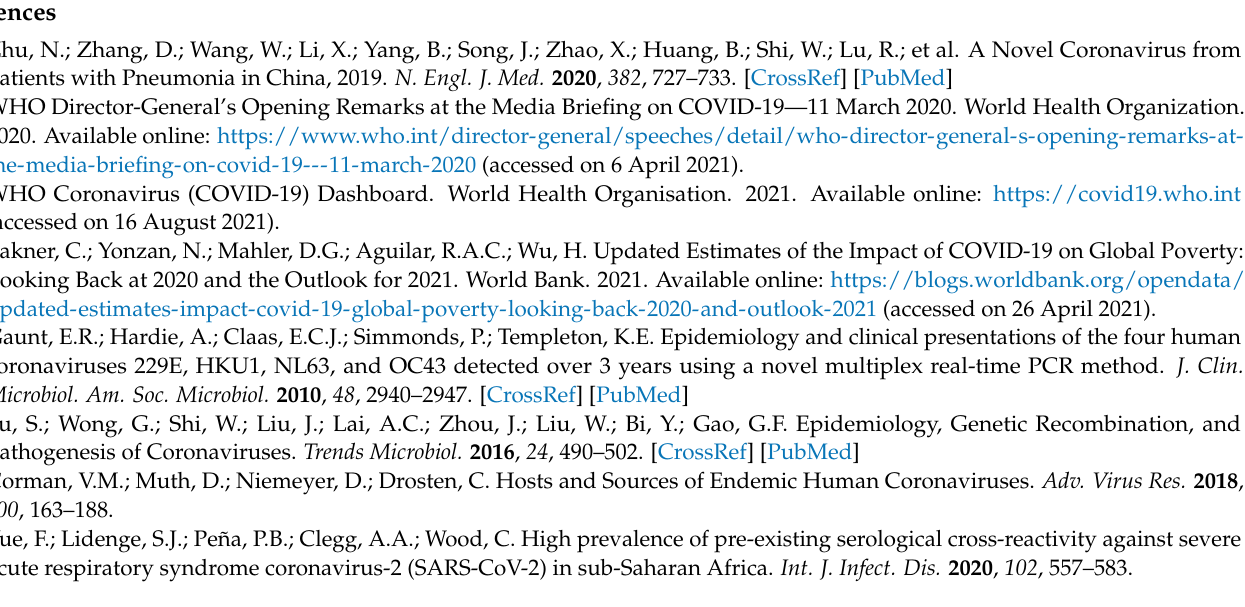
Figure S2: Reactivity to SARS-CoV-2, OC43, HKU1, NL63, 229E spike and N antigens in pre-pandemic and SARS-CoV-2 PCR-positive human serum samples; Figure S3: Inferring endpoint titers from minimal dilution series; Figure S4: Dilution series of OC43 and HKU1 S1S2; Table S1: Summary of human serum panels; Table S2: Comparison of inflection titers inferred from 8 dilutions and 3 spread out dilutions (1:40; 1:640; 1:10,240) for three SARS-CoV-2 antigens; Table S3: Comparison of endpoint titers inferred from 8 dilutions and 3 spread out dilutions (1:40; 1:640; 1:10,240) for three SARS-CoV-2